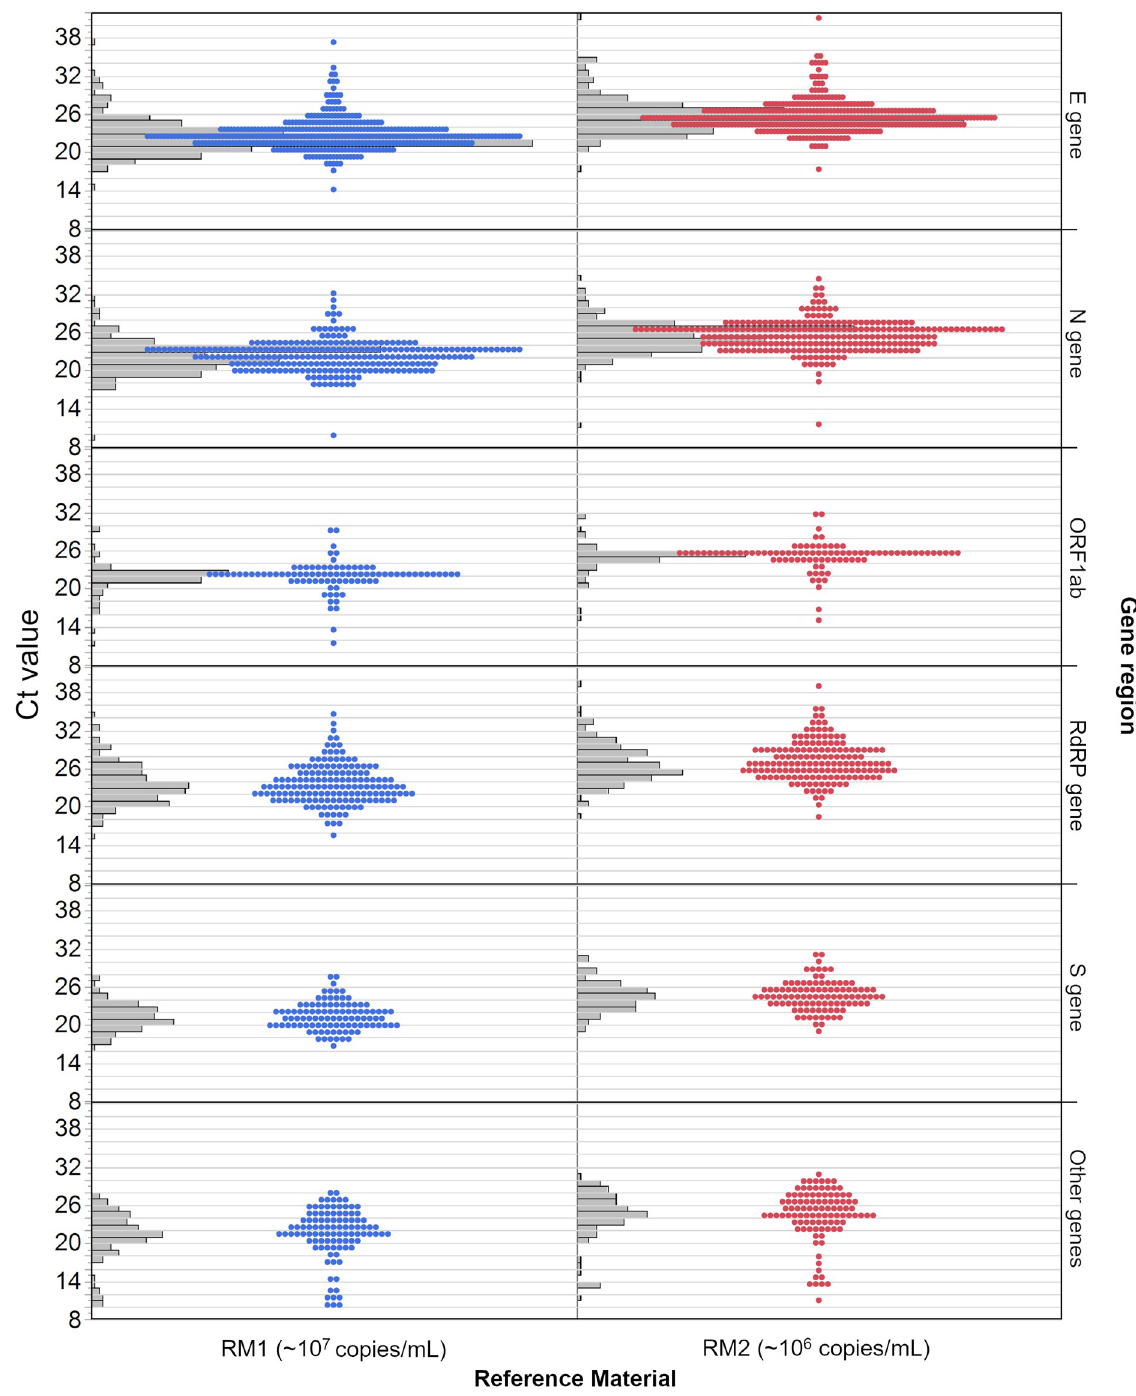
Fig 4. Distribution of all Ct values of participants per gene region. The concentration of RM 1 (blue) is estimated at roughly 10 7 copies/mL and the concentration of RM 2 (red) is estimated at roughly 10 6 copies/mL. Grey bars represent the distribution of results, which is also represented by the dots. Each dot indicates one